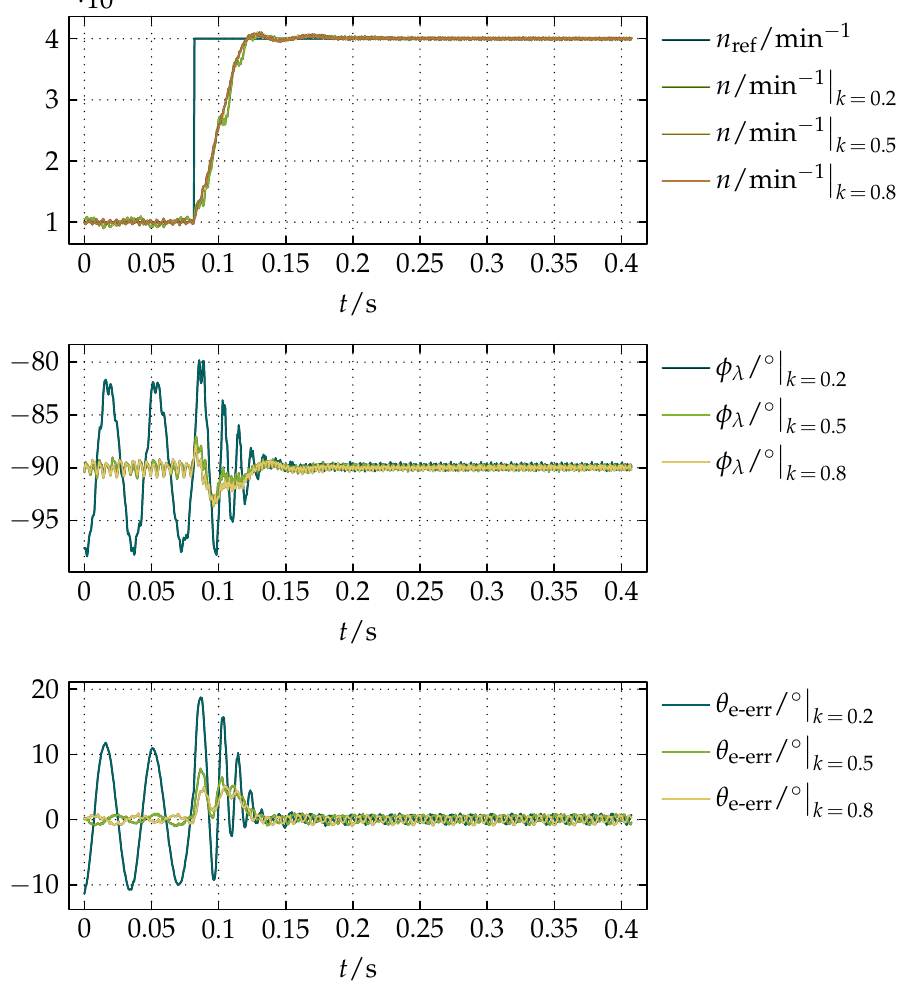
Figure 17. Results of comparative experiments of a step in n from 1000 to 4000 min − 1 for ω c = ω n and variations in k